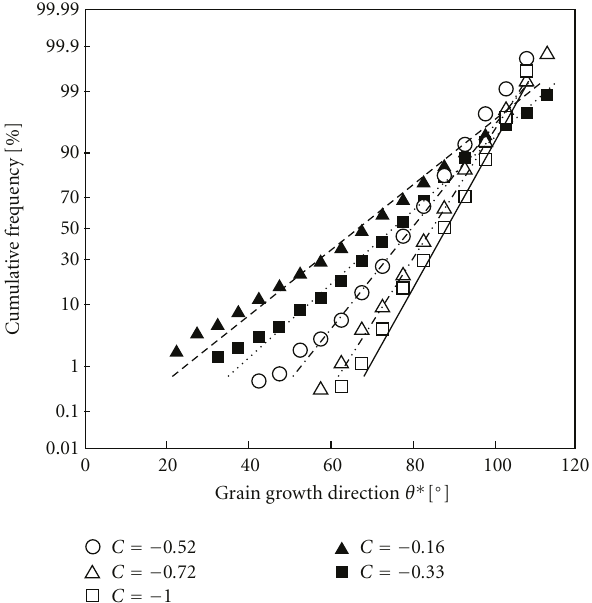
Figure 11: Grain growth direction plotted on normal probability paper.